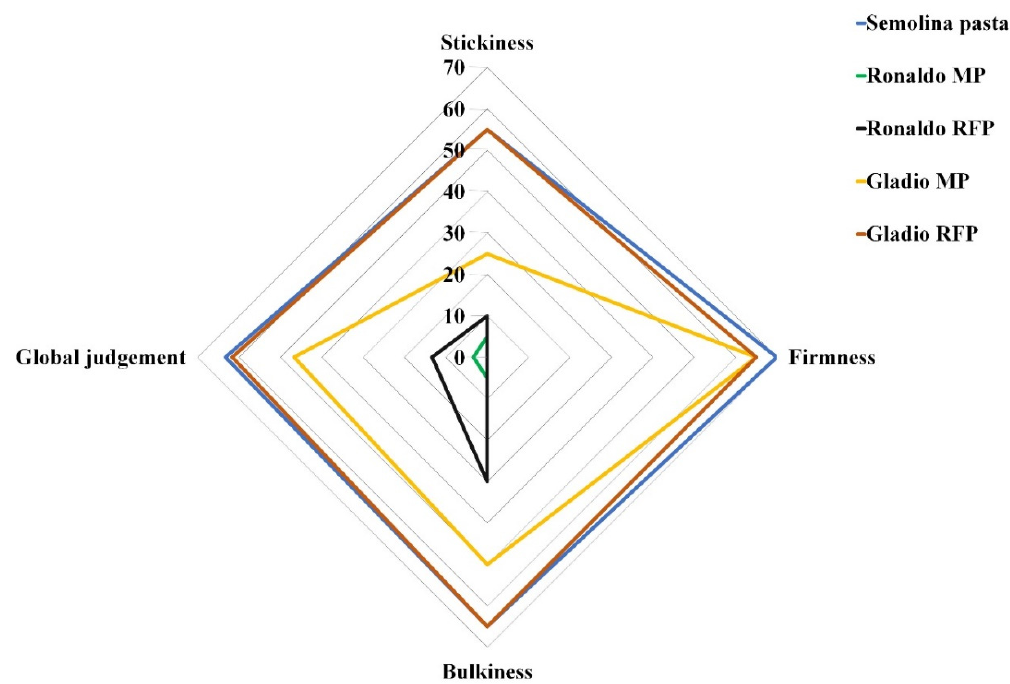
Figure 4. Radar chart of sensory assessment of rice and semolina pasta. MP = Micronized Pasta; RFP = Refined + F Fraction Pasta. For stickiness and bulkiness: ≤ 20 = very high, >20 and ≤ 40 = high, >40 and ≤ 60 = rare, >60 and ≤ 80 = almost absent, >80 and ≤ 100 = absent; for firmness, ≤ 20 = absent, >20 and ≤ 40 = rare, >40 and ≤ 60 = sufficient, >60 and ≤ 80 = good, >80 and ≤ 100 = very good. Global Sensorial Judgement score ranges from 10 to 100: <55 = scarce, ≥ 55 and <65 = sufficient, ≥ 65 and <75 = good, ≥ 75 = very good.